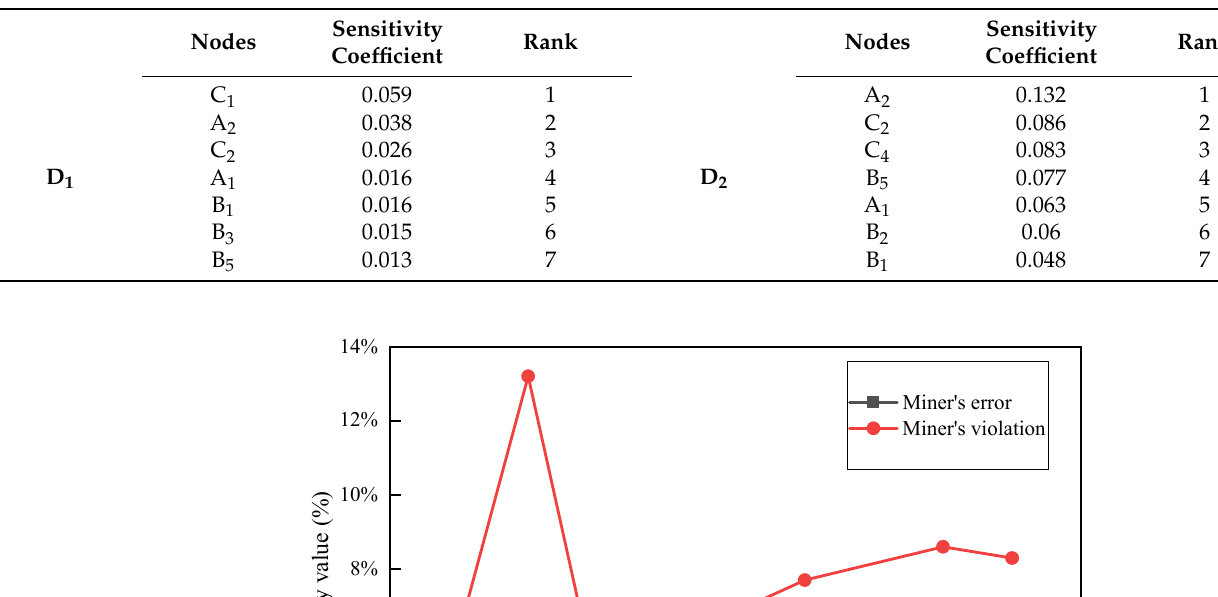
Table 7. Ranking table of sensitivity coefficients.